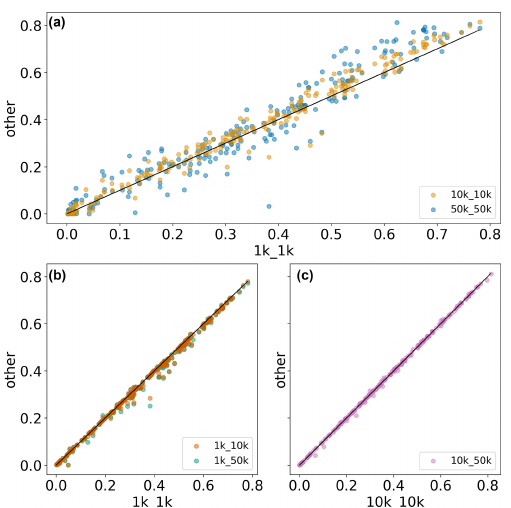
Figure B2. Scatterplot of the coefficient of determination ( R 2 ) values obtained in evaluation of simulated upper soil moisture with ESA-CCI data for (a) comparing different model resolu- tions, (b) comparing different forcing resolutions for 1K runs, and (c) comparing different forcing resolutions for 10K runs.